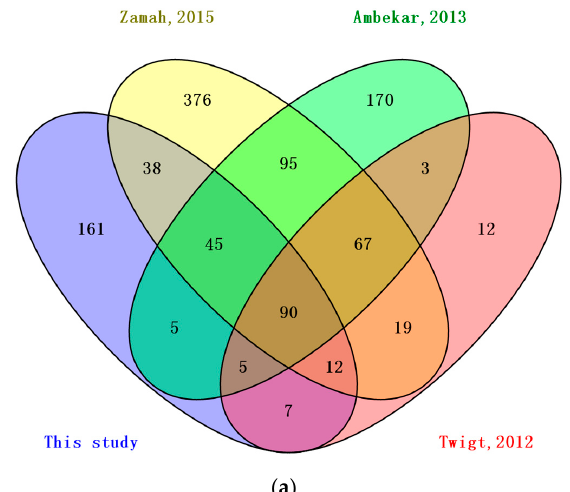
Figure 3. Cont. Figure 3.